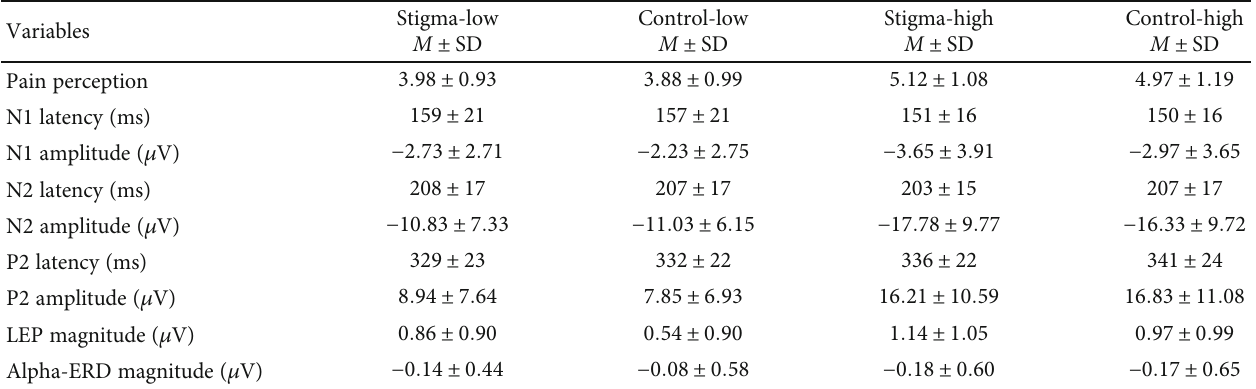
Figure 3: Laser-evoked potentials (N1 wave) in four experimental conditions. N1 amplitudes were signi fi cantly higher in the stigma condition than those in the control condition ( ∗ p < 0 : 05 ). Scalp topographies of N1 waves in four conditions were displayed at their peak latencies. Table 1: Pain perception and LEP responses in di ff erent experimental